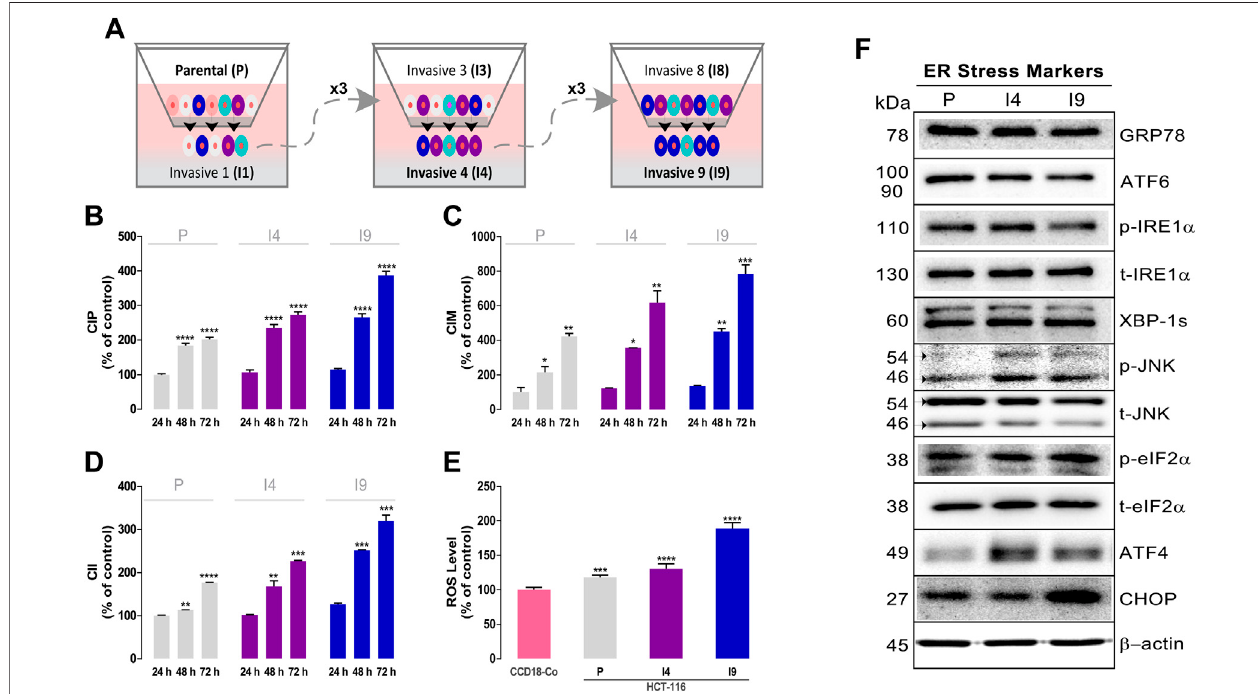
FIGURE5| IsolationandcharacterizationofsuperinvasivepopulationsofHCT-116cells. (A) Schematicrepresentationoftheisolationprocessoftheinvasive4(I4) and invasive 9 (I9) cell lines. A Real-Time Cell Analyzer (RTCA) dual-plate instrument (Roche Diagnostics GmbH, Germany) was used to measure the basal proliferation cell index (CIP) using an E-plate (B) , migration cell index (CIM) using a CIM-plate (C) , and invasion cell index (CII) using a CIM-plate coated with Matrigel (D) of the superinvasive populations of HCT-116. (E) ROS levels were measured using the 2 ′ ,7 ′ -dichlorodihydro fl uorescein diacetate (H 2 DCF-DA) fl uorescence label. Data are presented as the mean ± SD of three independent experiments. p -values were calculated by comparison with the control (untreated cells plus less than 0.2% dimethylsulfoxide,C)usingANOVA.* p -value < 0.05,** p -value < 0.01,*** p -value < 0.001,and**** p -valu e < 0.0001. (F) ThebasallevelsofERstress – relatedproteins in superinvasive HCT-116 populations were assayed using western blot analysis. β -Actin was used as a loading control. The experiment was repeated twice. (Densitometric analysis is shown in Supplementary Figure S9 )